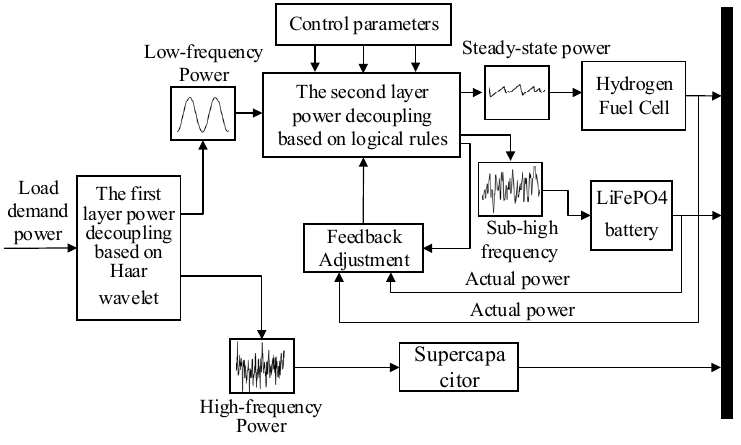
Figure 8. Multi ‐ layer energy management strategy. Figure 8. Multi-layer energy management